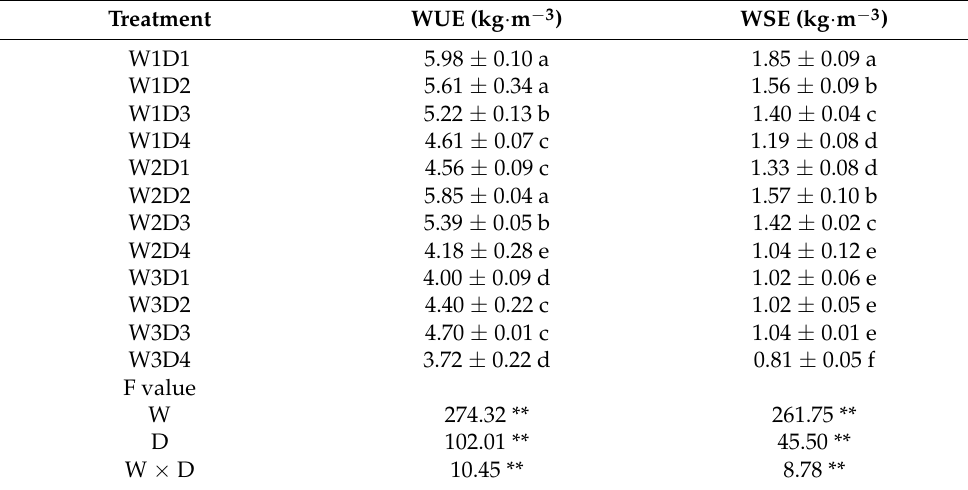
Table 6. Effect of different planting densities and irrigation volumes on the WUE and WSE of Suaeda salsa under drip